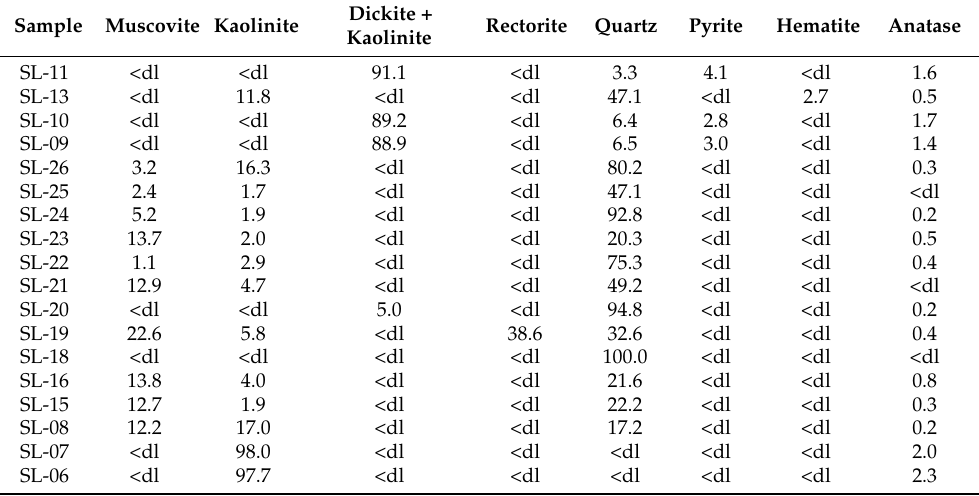
dl, below detection